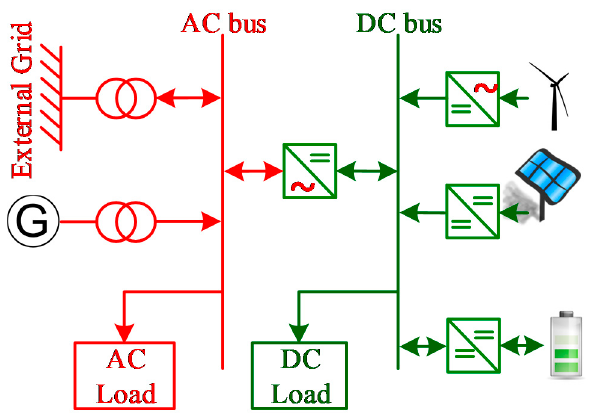
Figure 8. Hybrid AC-DC architecture for smartgrids.